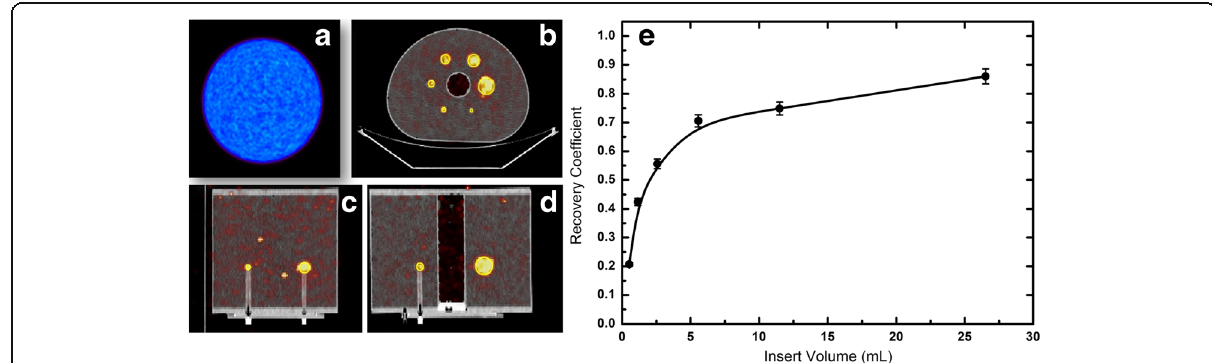
Fig. 1 Quantitative accuracy of 90 Y – PET acquisitions. a Cylindrical phantom used for validating PET calibration uniformly filled with an activity concentration of 90 YCl 3 at a concentration of 273 ± 14 kBq mL − 1 at the time of acquisition. Diethylenetriaminepentaacetic acid (DTPA) at a concentration of 100 μ g g − 1 was used to prevent binding of 90 Y to the phantom PMMA walls. An overnight (16 h) single bed acquisition was performed. b Transversal slice of the NEMA IEC/2001 phantom used for the assessment of recovery coefficients needed for partial volume corrections. RCs are defined as the ratio of the measured activity concentration to true activity concentration. The phantom is provided with six fillable spheres of varying volume (0.52, 1.15, 2.57, 5.57, 11.49, and 26.52 mL), each filled with an activity concentration of 2.28 ± 0.11 MBq mL − 1 at the time of acquisition. Sagittal ( c ) and coronal ( d ) view of the same phantom are also shown. e Recovery coefficients as a function of the volume of the sphere. RCs lie in the range 0.2 – 0.86 for the smallest sphere and largest sphere, respectively. The relative uncertainty was estimated to be 5% of the RC value, corresponding to the relative uncertainty associated with the activity as measured by the clinical radionuclide